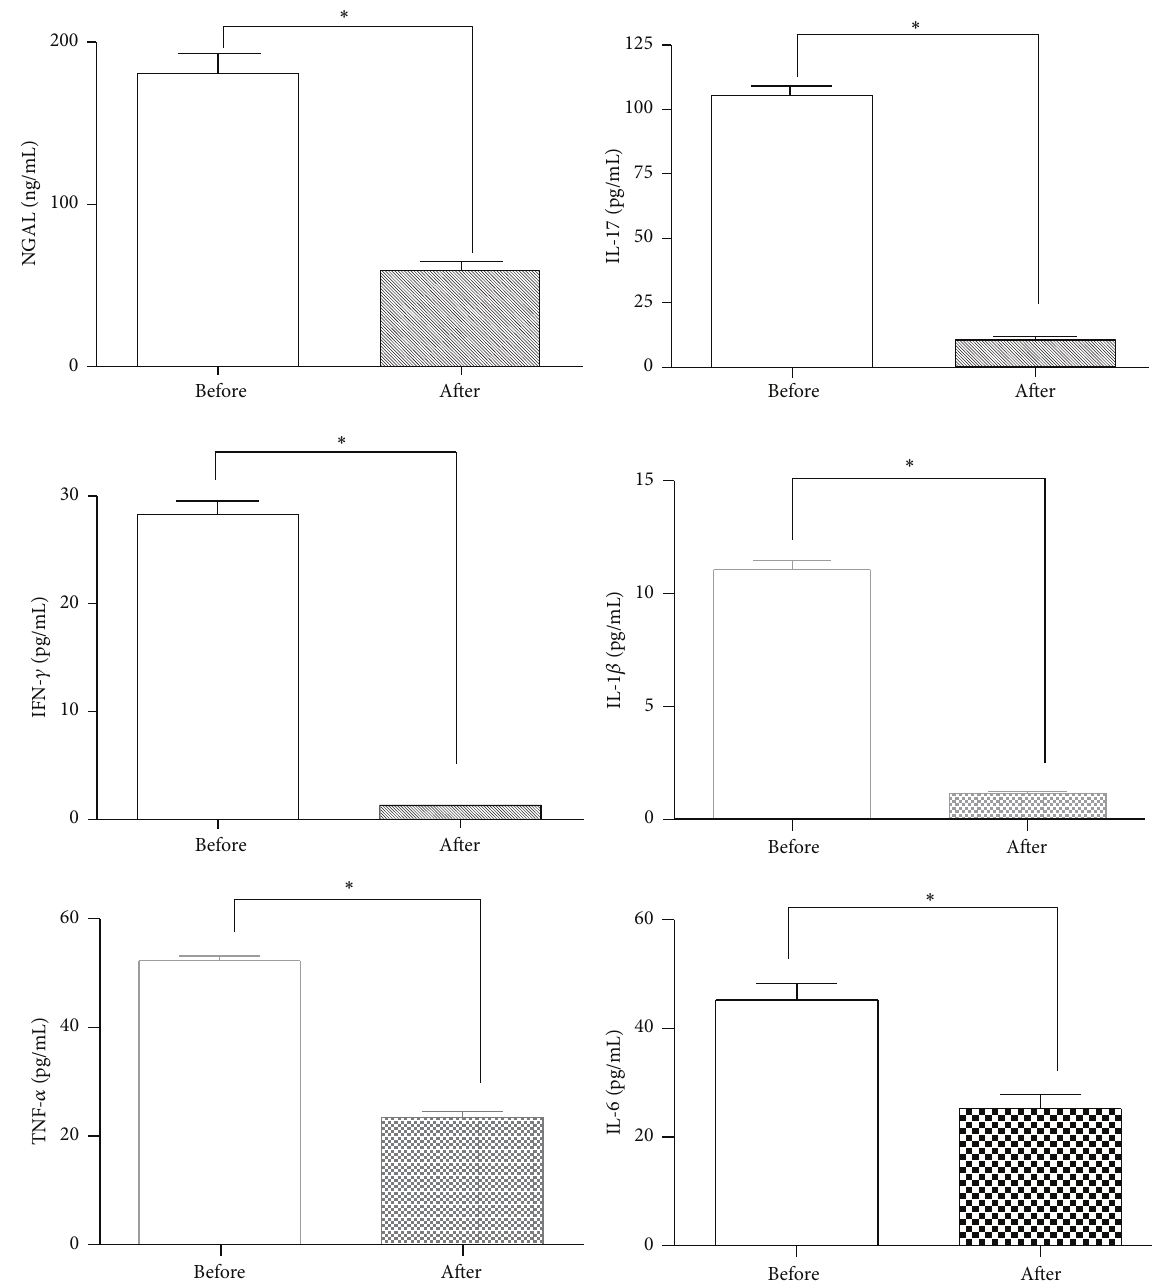
Figure 1: Values of serological parameters, before and after paracalcitol supplementation. A significant reduction (𝑝 < 0.0001) in NGAL valuesandincytokinelevels(IL-17,IFN-gamma,IL-1beta,TNF-alfa,andIL-6)occurredfromplasmasamplesobtainedfromallCKDpatients ∗ 𝑝 < 0.0001 .